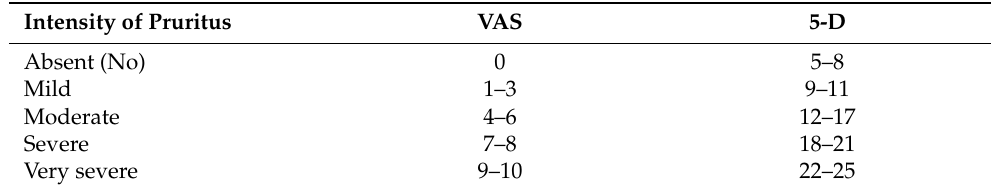
Table 2. Definition of the ordinal pruritus variables from the visual analogue scale and 5-D itch scale. VAS: Visual analogue scale, 5-D: 5-D itch scale.